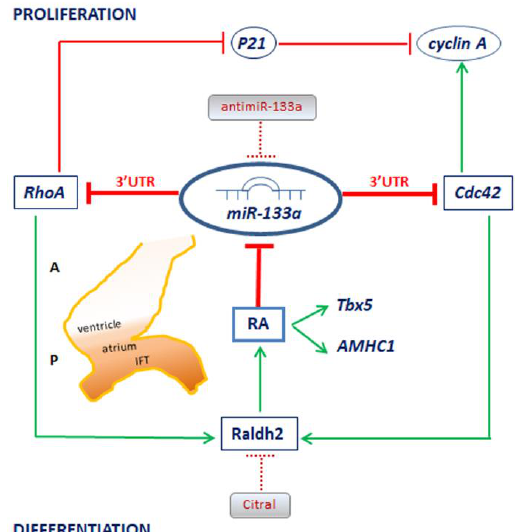
Figure 7. Model proposed for the interplay between miR-133a and RA during posterior heart tube formation. Our model indicates that miR-133a downregulates RhoA and Cdc42. Consequently, Raldh2 downregulation is induced by miR-133a, via these Rho GTPases. RA synthesis is Raldh2-dependent. Thus, miR-133a modulates RA signalling via Raldh2 expression. Also, RA negatively modulates miR-133a expression during the early genetic programme of the sinoatrial region. Additionally, our model indicates that miR-133a modulates cell proliferation by acting on the cell cycle regulators p21 (via RhoA) and cyclin A (via Cdc42). We hypothesise that there is a negative feedback mechanism between miR-133a and RA signalling during early development of the posterior cardiac tube segment. A: anterior segment, P: posterior segment.